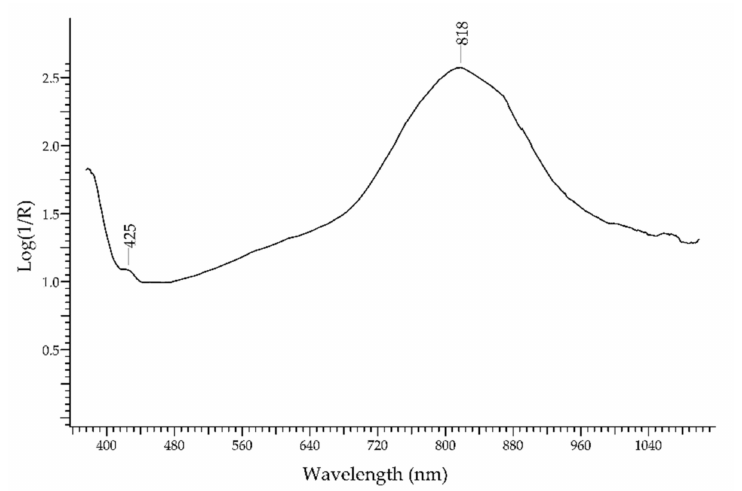
Figure 3. FORS spectrum in Log(1/R) coordinates of